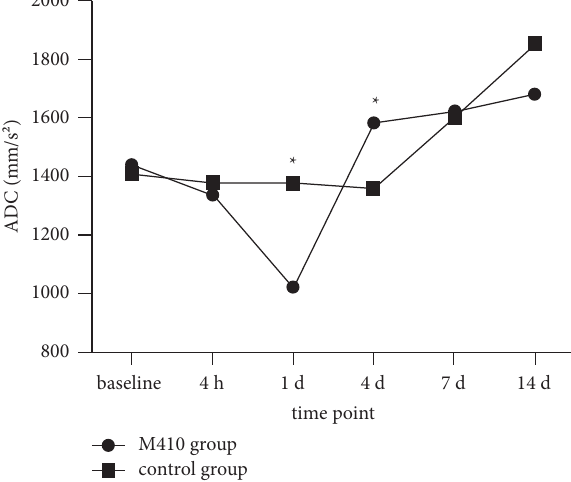
Figure 3: Changes in the mean apparent diffusion coefficient (ADC) value of the entire tumor of two groups at different time points. The mean ADC values of the entire tumor of the M410 group decreased from the baseline to day 1, then increased gradually until day 14. The control group values fell slightly from the baseline to day 4, then increased until day 14. There were statistically significant differences in the mean ADC values of the entire tumor between the two groups at the time points of d 1 and d 4 ( P � 0 . 032 , 0 . 012).